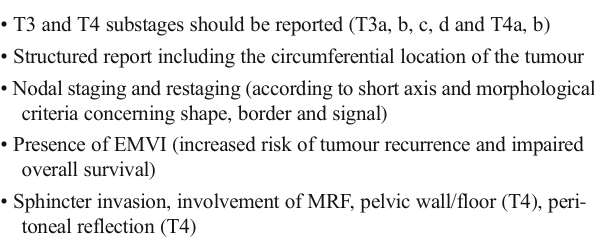
Main updated imaging interpretation and reporting recommendations by 2016 ESGAR consensus meeting